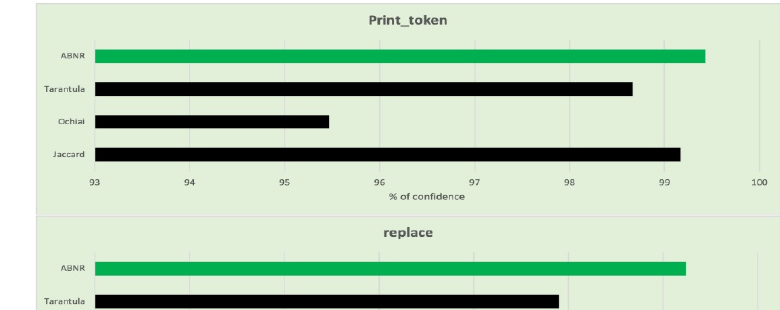
Table 9. Denote the confidence level of fault detection from Unix utility applications.